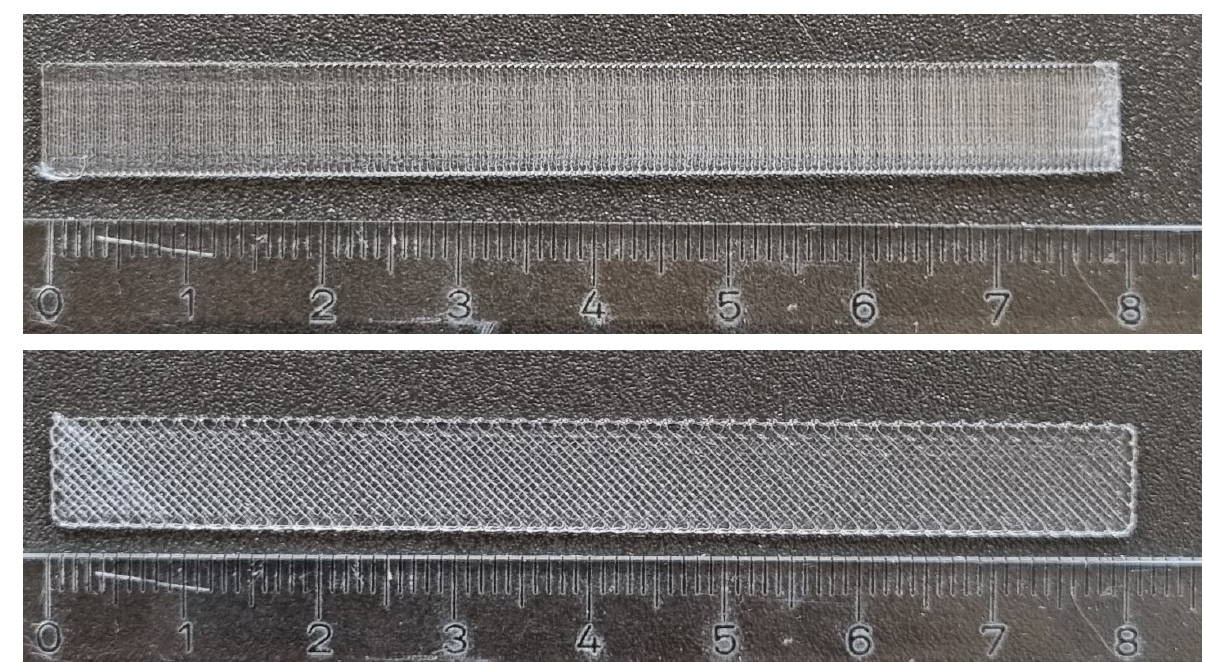
Figure 17. The 3D printed 0°, 90° and − 45°/45° orientated specimens of the type A material.